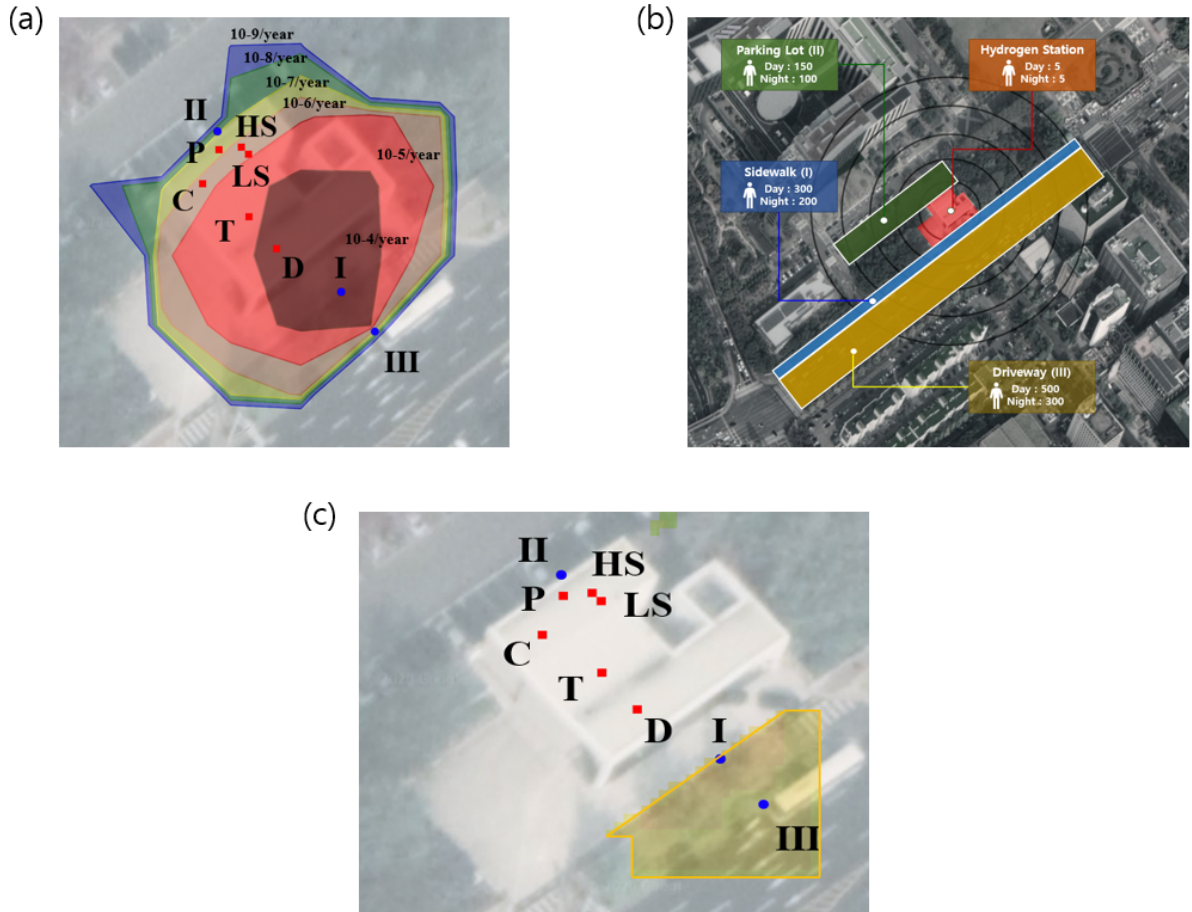
Figure 2. Contour mapping of individual risk in hydrogen refueling stations: ( a ) risk of each facility, ( b ) details of three locations, and ( c ) contribution of individual risk in each place without IPLs.